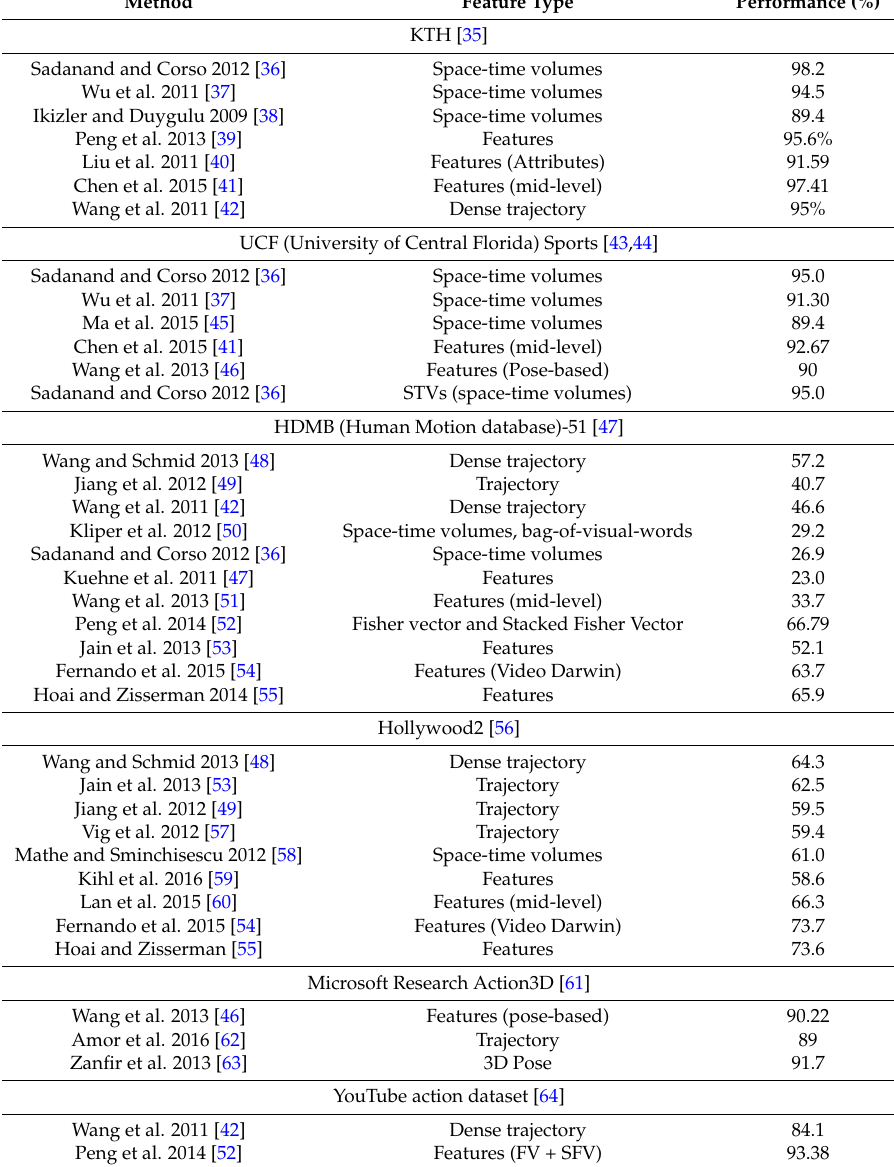
Table 1. Comparison of Space-Time-based approaches for activity recognition on different